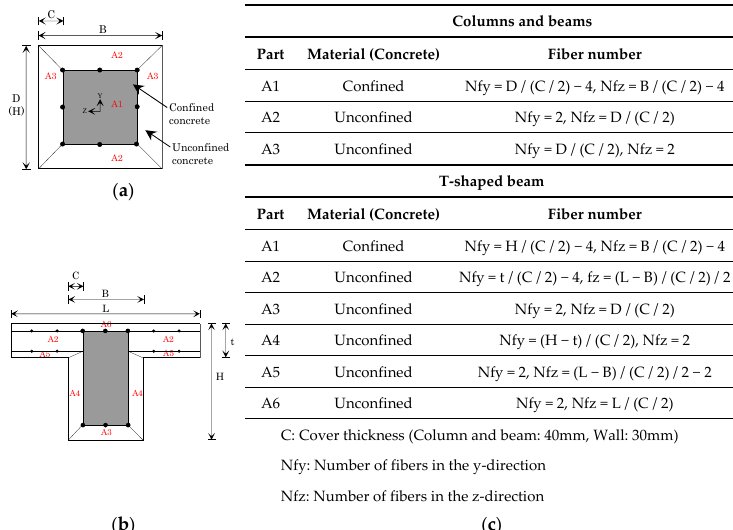
Figure 4. Modeling of structural elements: ( a ) columns and beams; ( b ) T-shaped beams; and ( c ) rules pertaining to fiber representations.